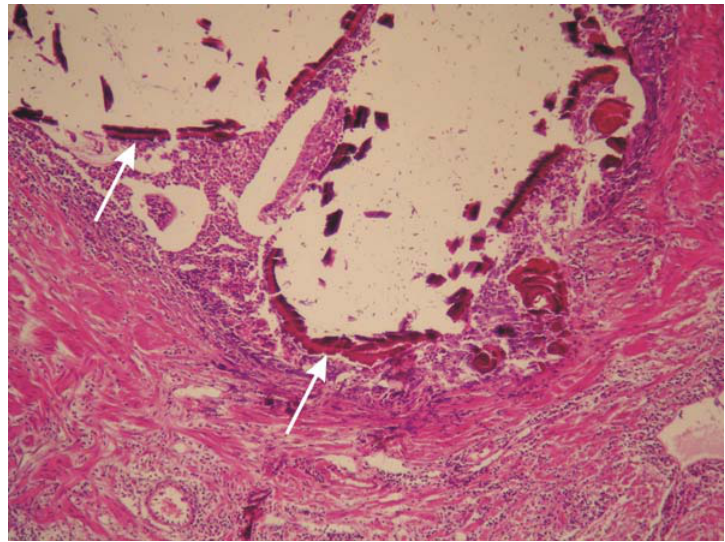
FIGURE 2. Photomicrograph of a prostate resection chip showing a calcified hydatid cyst wall (arrow) within the prostatic